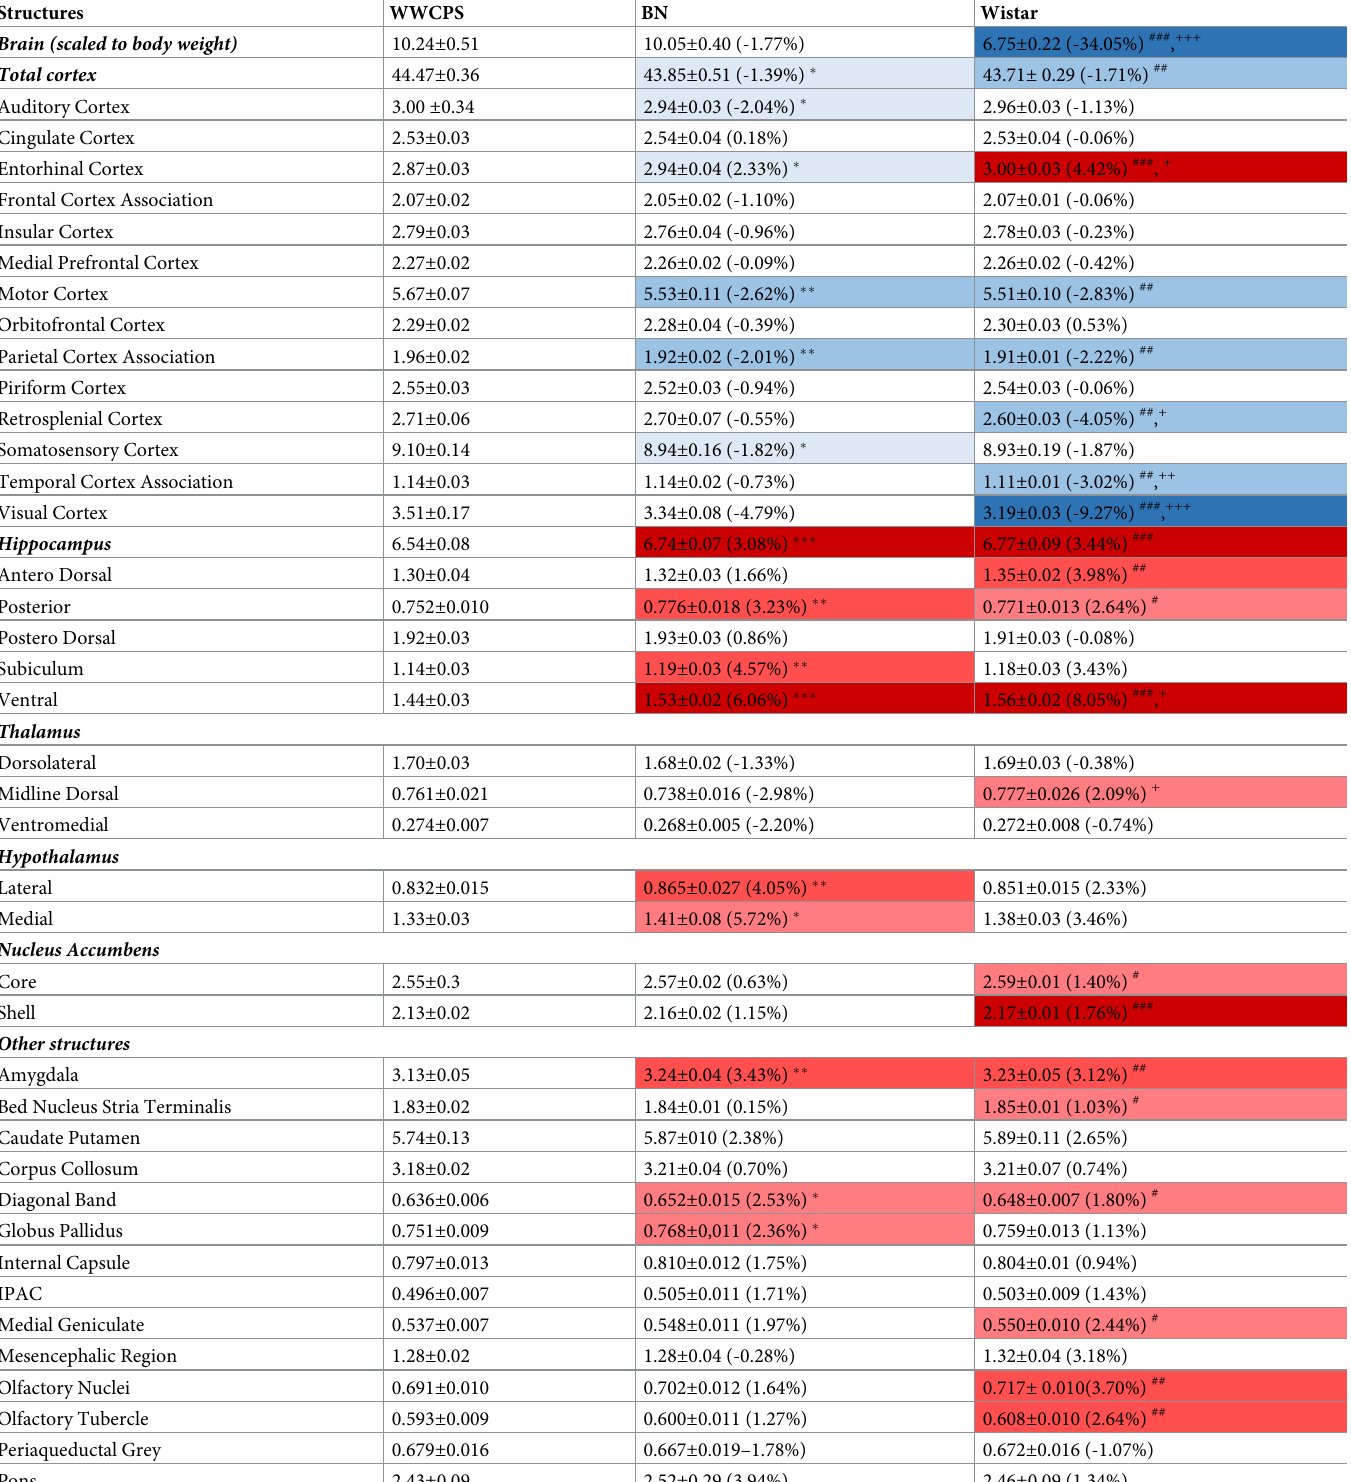
Table 1. Mean brain to body weight ratio ( ± SD) and mean percentage of various brain structures in WWCPS, BN and Wistar rats (ie. normalized